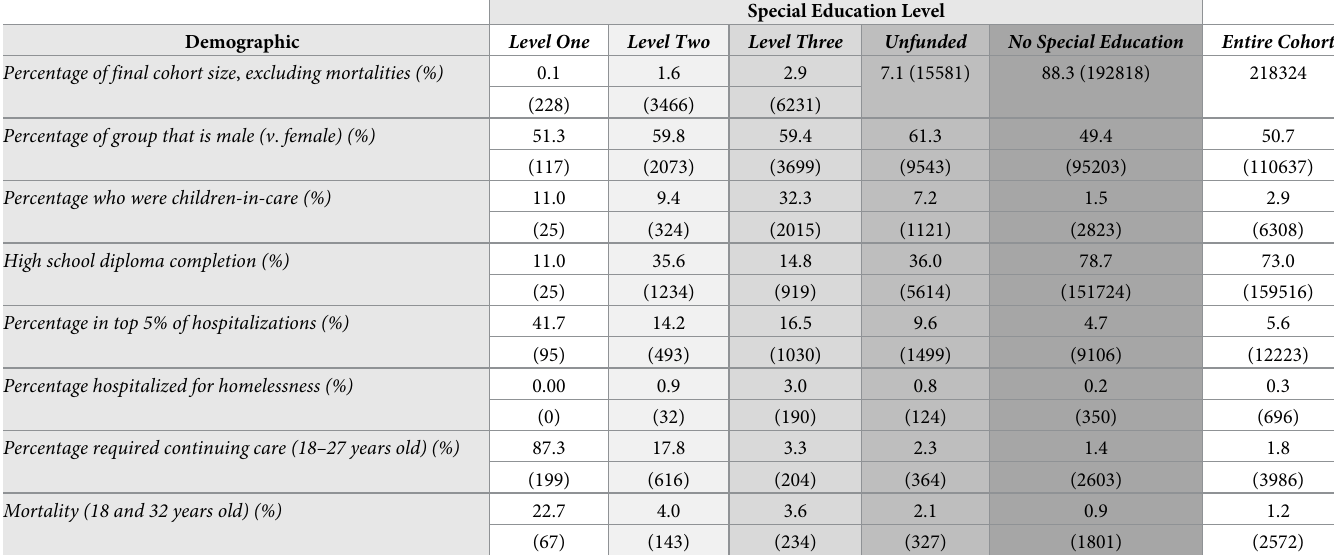
Table 2. Cohort demographics by level of special education funding. Percentages are presented, with number of individuals in